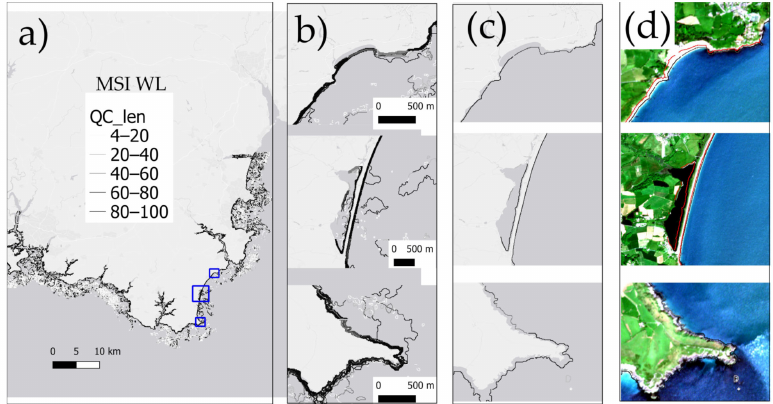
Figure 9. Waterlines and shorelines derived from Sentinel 2 between November 2015 to October 2019 for the Start Bay study area; ( a ) all waterlines in grey scale graded by value of QC_len; ( b ) zoom to three different areas over a Light Gray Canvas Base map; ( c ) zoom to same areas shown in b but now with a single waterline extracted from image taken near low tide 11:21 UTC 25/05/2017 in gray scale; ( d ) zoomed view with S2 image taken11:21 UTC 25/05/2017 as a base map and shoreline MSL in red in addition to waterline in grey scale. Source of Light Gray Canvas Base map: Esri, HERE, Garmin, © OpenStreetMap contributors, and the GIS user